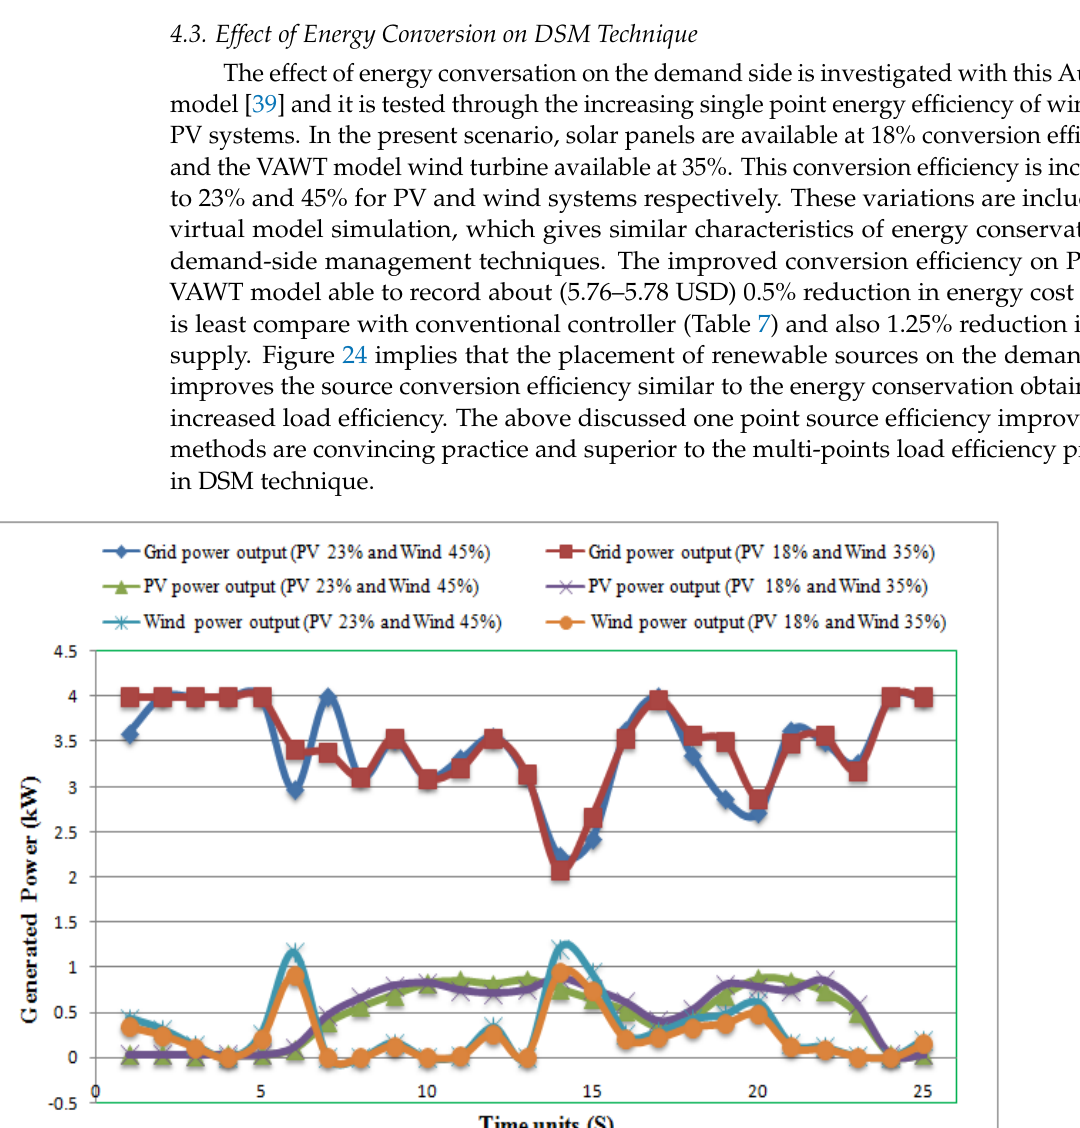
Table 7. Summary of results for the energy efficiency improvements.